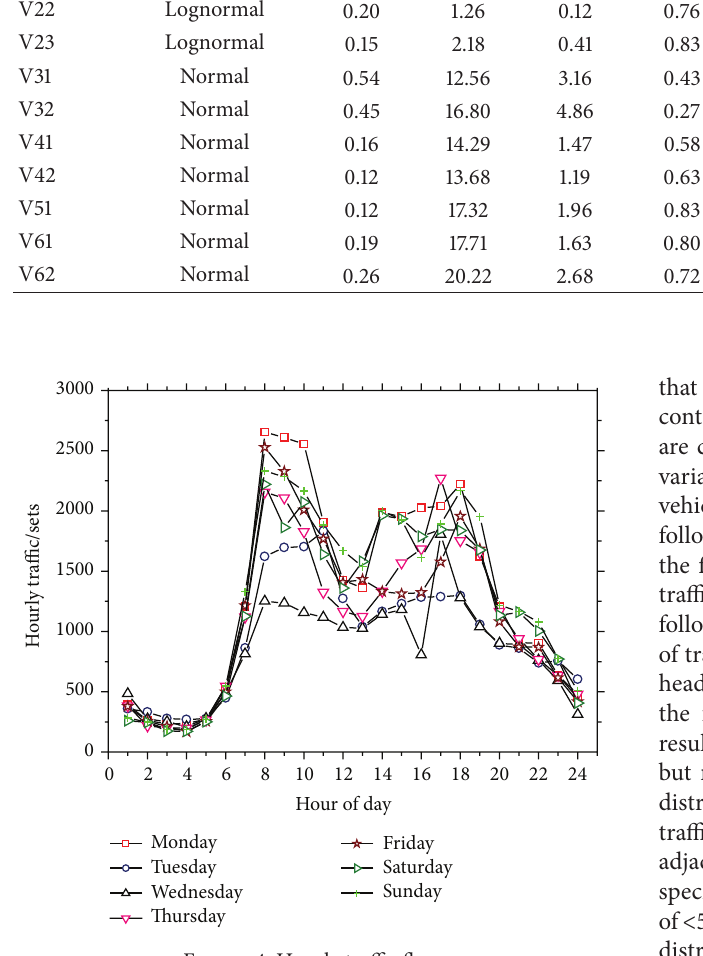
Figure 4: Hourly traffic